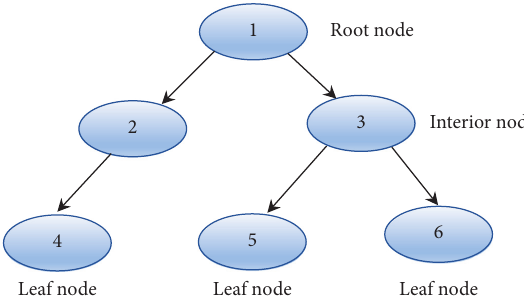
Figure 1: A simple example of the decision